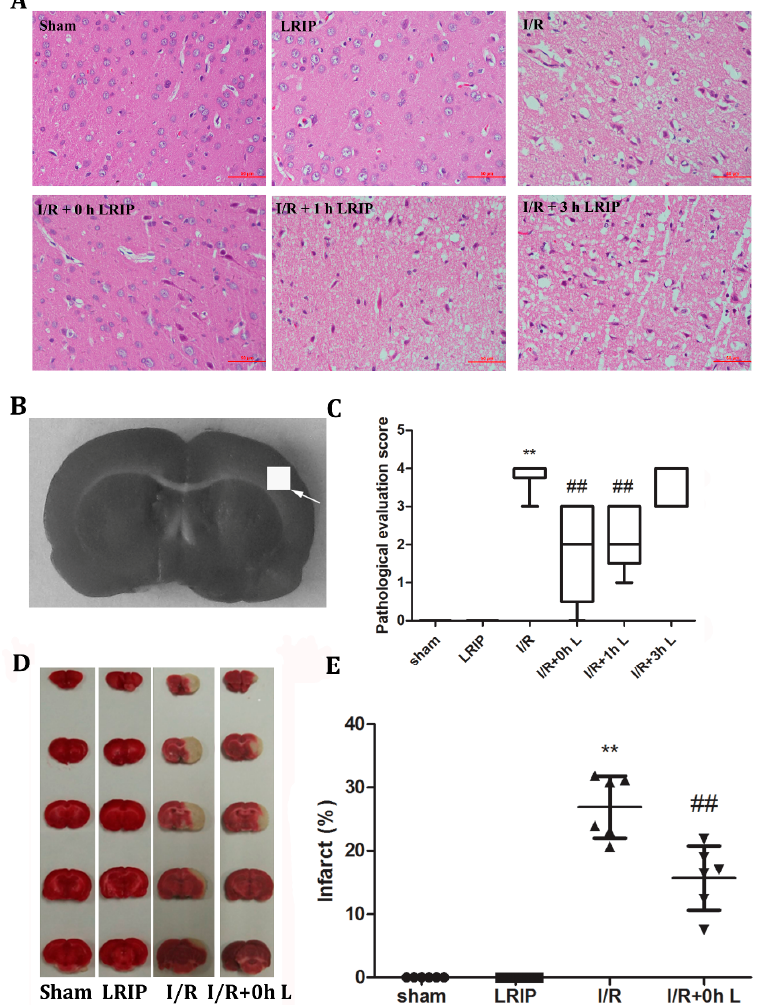
Figure 3. LRIP ameliorated histopathological changes and infarct size of the brain. ( A ) Brain sections of rats in different groups were stained by Hematoxylin and Eosin and then examined using a light microscope. Representative photomicrographs of ischemic cortices from the sham, LRIP, I/R, I/R + 0 h, I/R + 1 h, and I/R + 3 h groups were established. The most significant reversal of injury was observed in the I/R + 0 h group. The magnification was 400 × . Scale bar = 50 µ m; n = 6; ( B ) rat brain slices were obtained by making a coronal cut through the optic chiasma. Tissue corresponding to the square icon was used for Hematoxylin and Eosin Staining; ( C ) histopathological scores of paraffin sections of the rat brain; ( D ) representative infarcts stained by 2,3,5-triphenyhetrazolium chloride (TTC); ( E ) bar graphs show the average infarct size of the five slices. Data are expressed as mean ± SD, n = 6, ** p < 0.01 vs. sham group, ## p < 0.01 vs. I/R